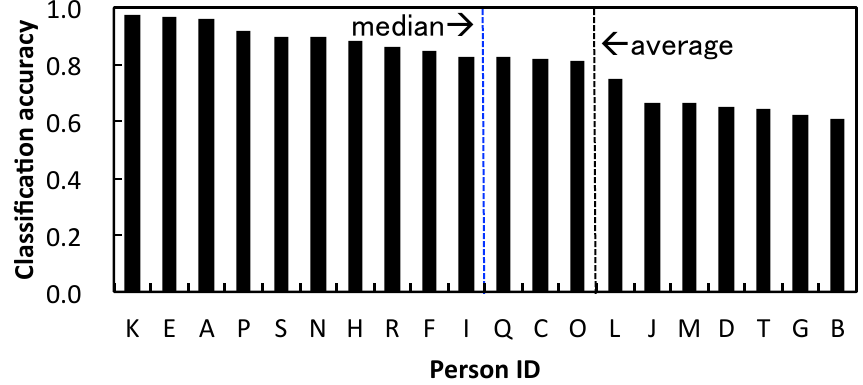
Figure 8. Classification accuracy per person sorted by the